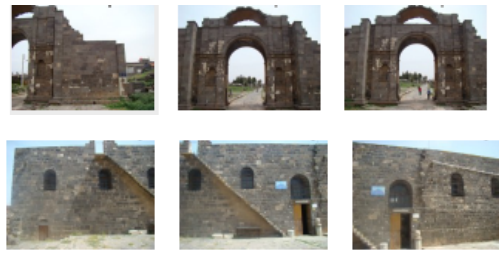
Figure 3. Selection of photos of the monuments